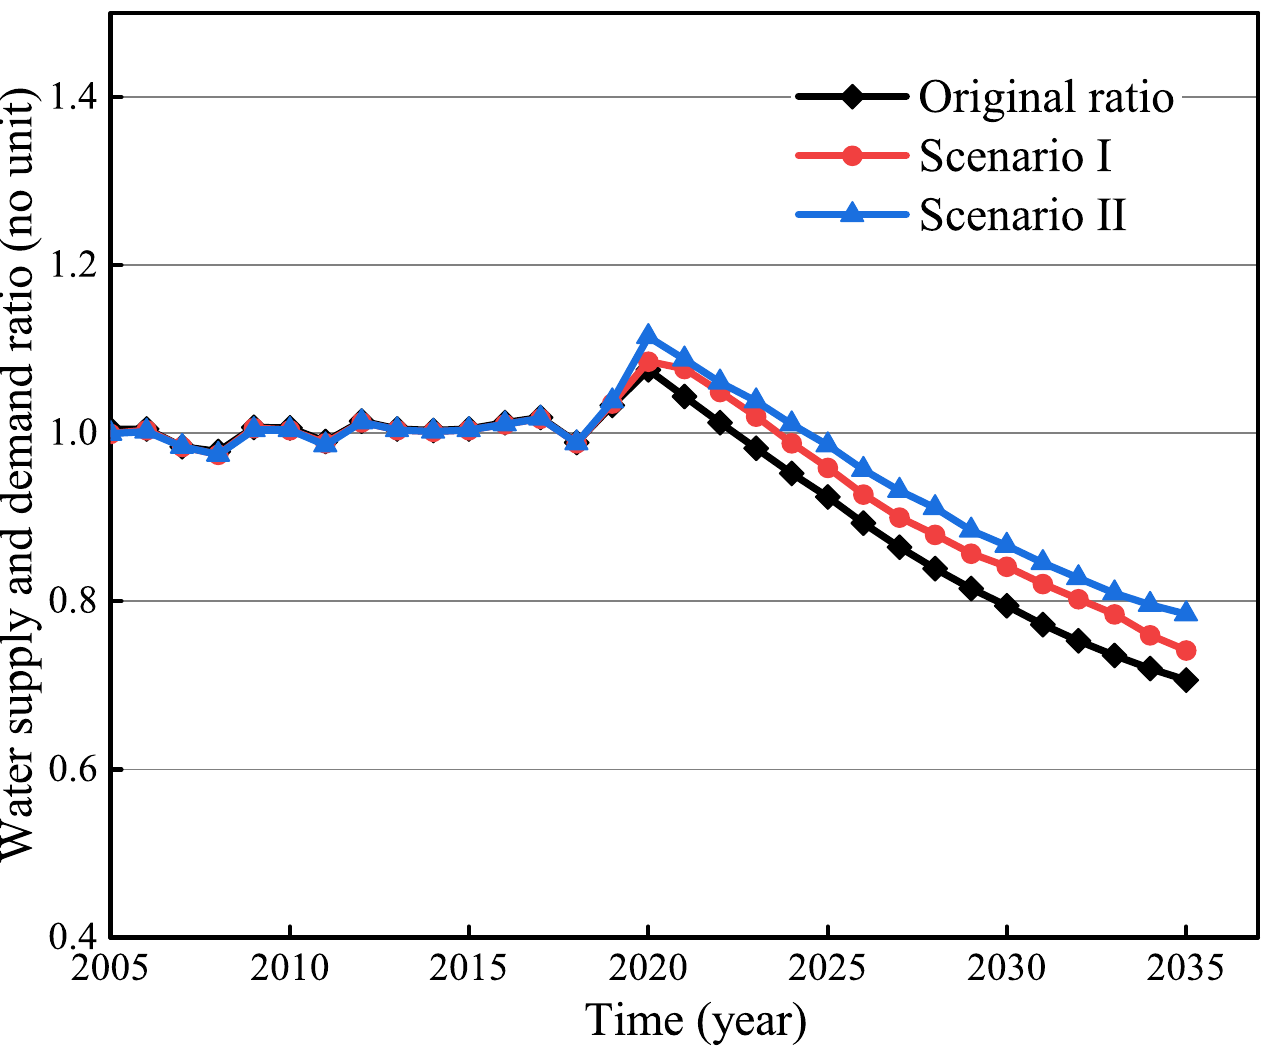
Fig 6. Optimization simulation results of household water